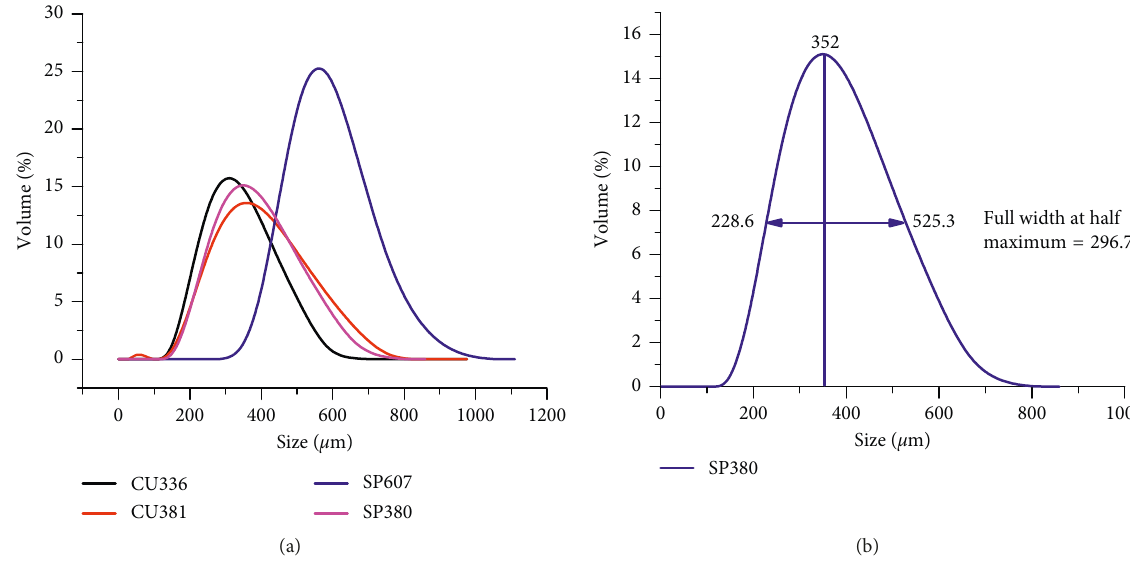
Figure 2: (a) The particle-size distribution of KCl is used, where CU336 is a cubic KCl with a mean particle size of 336 µ m ( D D 90 � 475 μ m), CU381 is a cubic KCl with a mean particle size of 381 µ m ( D 10 � 224 μ m, D 90 � 541 μ m), SP607 is a spherical KCl with a mean particle size of 607 µ m ( D 10 � 468 μ m, D 90 � 755 μ m), and SP380 is a spherical KCl with a mean particle size of 380 µ m ( D 10 � 241 μ m, D 90 � 544 μ m). (b) An example for calculating the full width at half maximum for the space holder SP380.